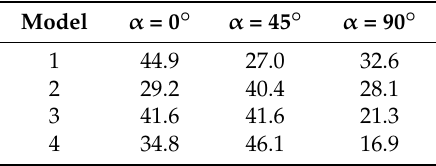
Table 2. Percentage of Gaussian